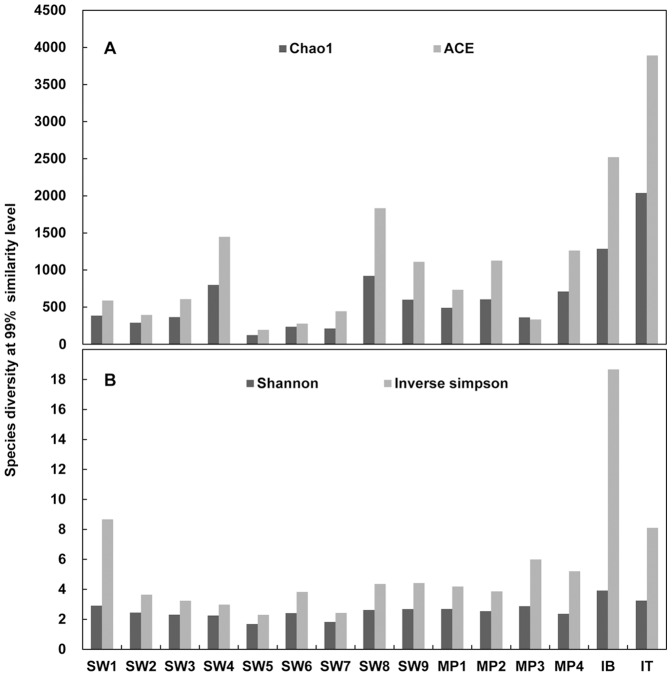
Alpha diversity analysis.Species diversity is represented on a local scale (for all samples) at a 99% similarity level (patterns of 97%, 95%, and 90% are similar with 99%, not shown here). (A) Species richness is expressed by the Cho1 and ACE indices and denotes the number of taxa in a community. (B) Species evenness denotes the measure of the relative abundance of taxa and is expressed by the Shannon and Simpson indices. The values of the Simpson index were converted to be shown in the same graph and are represented by the Inverse Simpson Index.